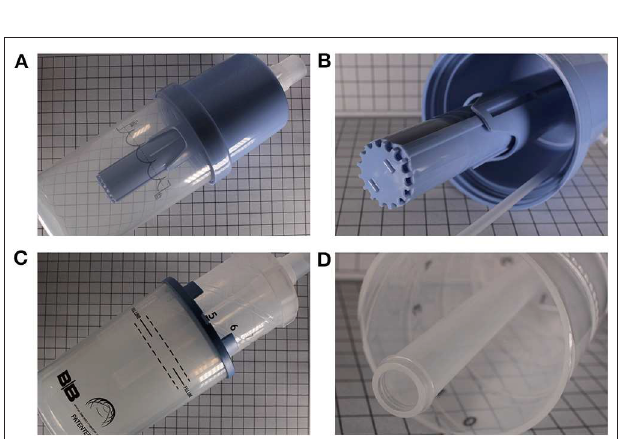
FIGURE 2 | Two different commercially available bubblers. (A) Babi.Plus Bubble PAP Valve (GaleMed), with the diffuser at the expiratory end (B) . (C) B and B Bubbler (B and B Medical Technologies) without a diffuser at the expiratory end (D)